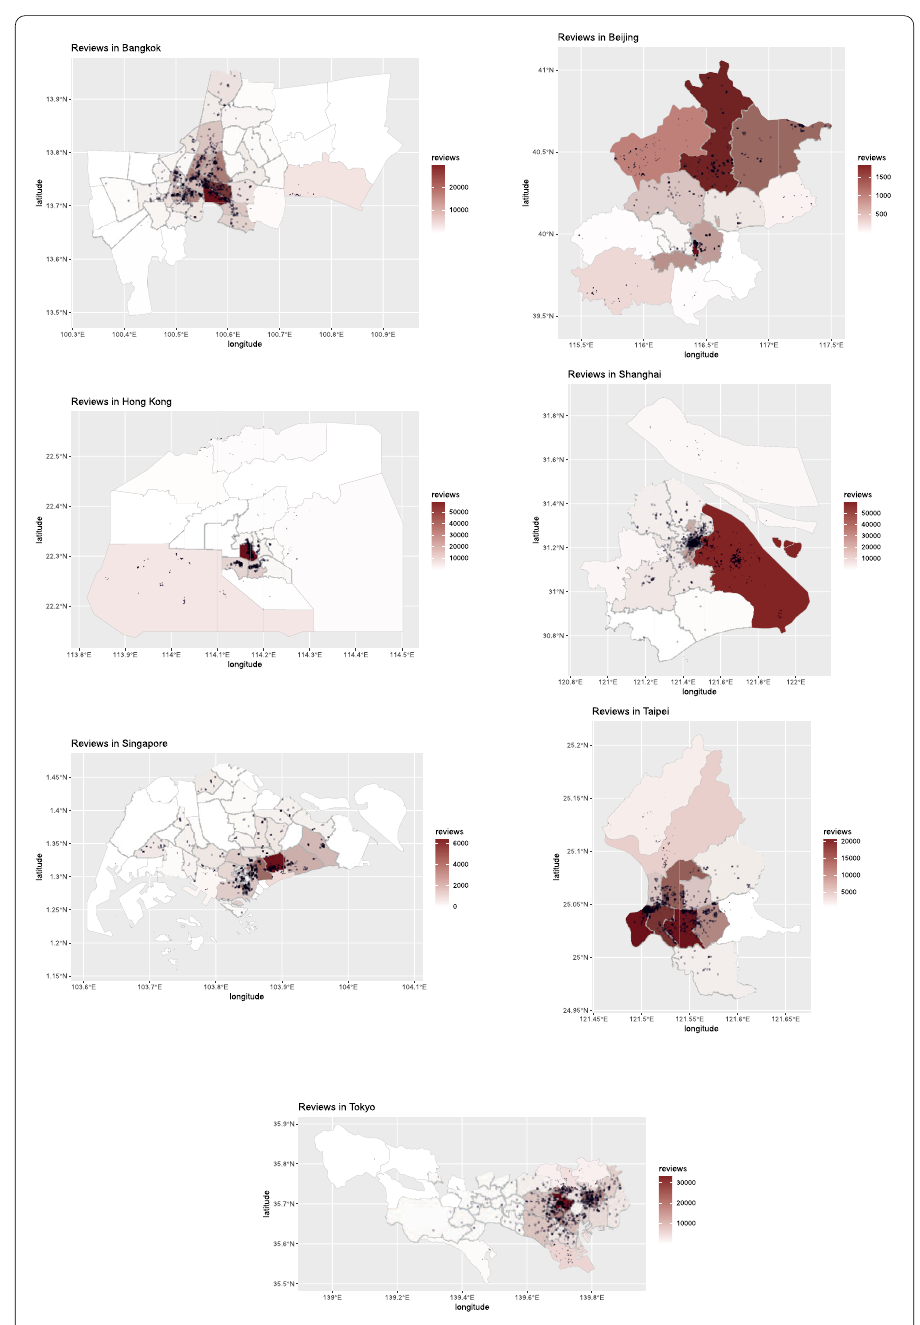
Figure 17 Demand (guest) density in the seven Asian cities